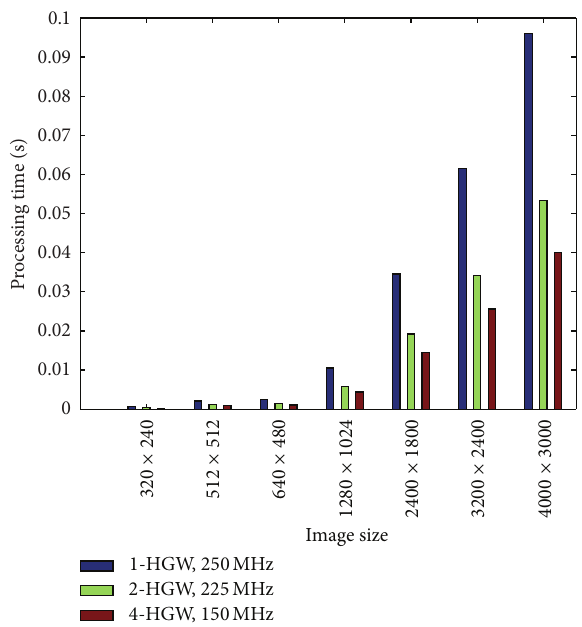
Figure 9: Processing time for different image sizes using three dif- ferent degrees of